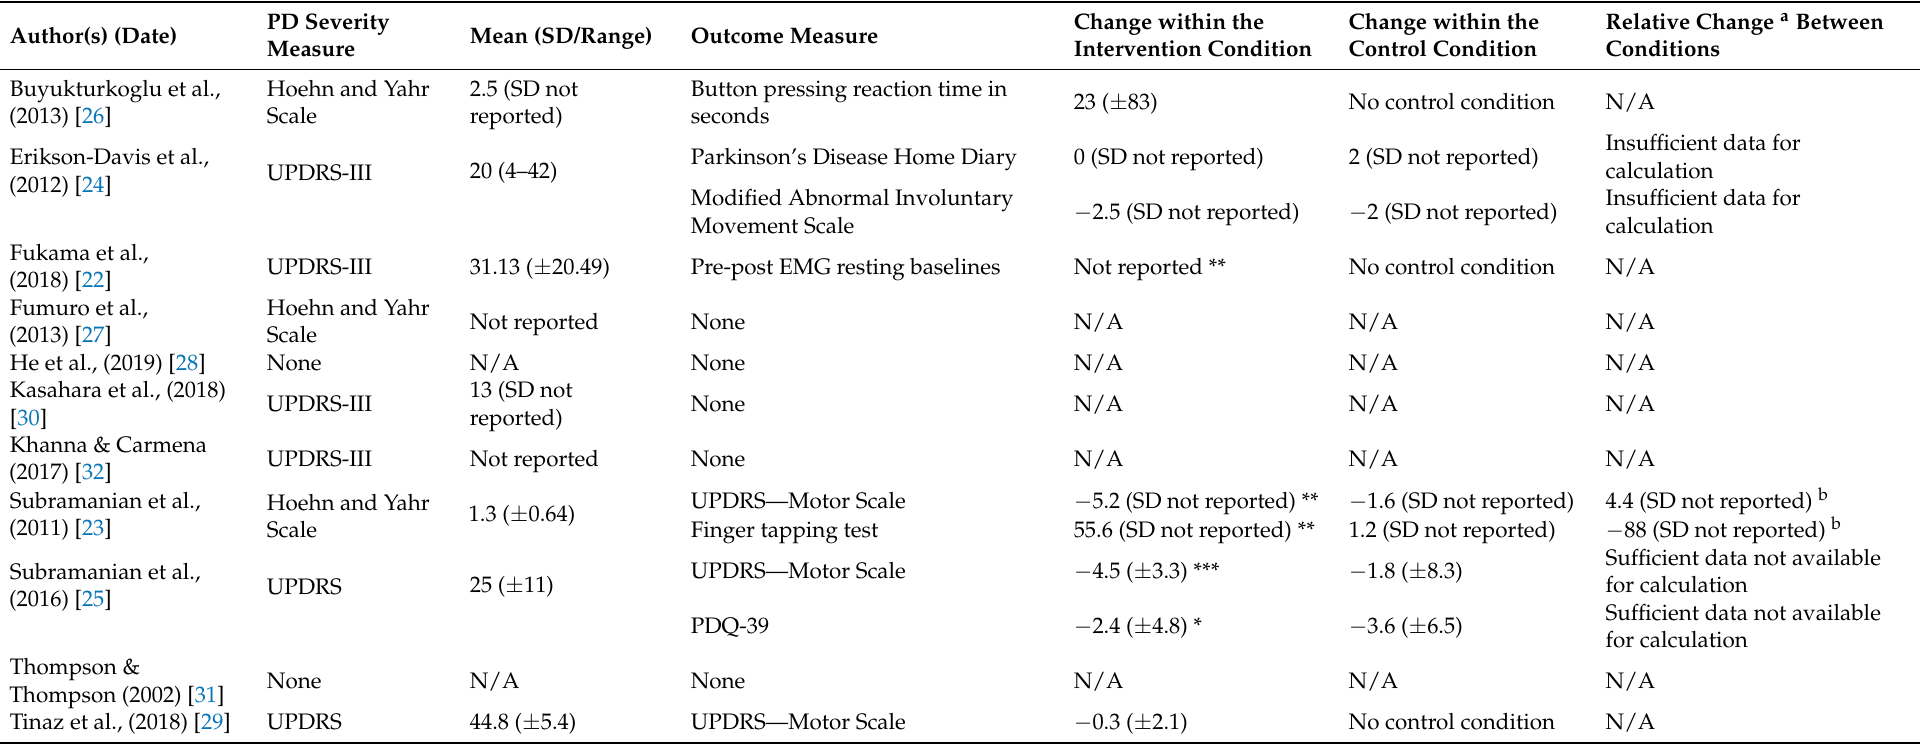
Table 3. Details of clinical outcome